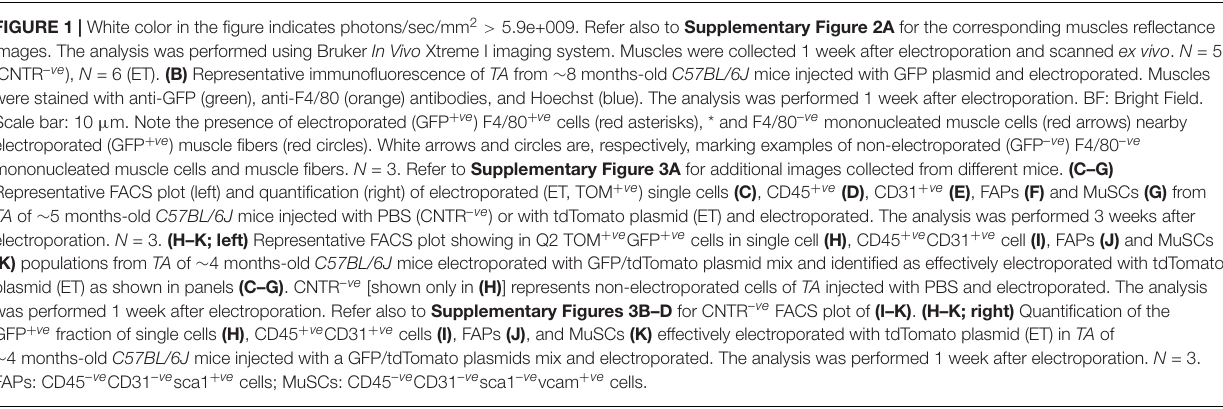
FIGURE 1 | White color in the figure indicates photons/sec/mm 2 > 5.9e+009. Refer also to Supplementary Figure 2A for the corresponding muscles reflectance images. The analysis was performed using Bruker In Vivo Xtreme I imaging system. Muscles were collected 1 week after electroporation and scanned ex vivo . N = 5 (CNTR – ve ), N = 6 (ET). (B) Representative immunofluorescence of TA from ∼ 8 months-old C57BL/6J mice injected with GFP plasmid and electroporated. Muscles were stained with anti-GFP (green), anti-F4/80 (orange) antibodies, and Hoechst (blue). The analysis was performed 1 week after electroporation. BF: Bright Field. Scale bar: 10 µ m. Note the presence of electroporated (GFP + ve ) F4/80 + ve cells (red asterisks), * and F4/80 – ve mononucleated muscle cells (red arrows) nearby electroporated (GFP + ve ) muscle fibers (red circles). White arrows and circles are, respectively, marking examples of non-electroporated (GFP – ve ) F4/80 – ve mononucleated muscle cells and muscle fibers. N = 3. Refer to Supplementary Figure 3A for additional images collected from different mice. (C–G) Representative FACS plot (left) and quantification (right) of electroporated (ET, TOM + ve ) single cells (C) , CD45 + ve (D) , CD31 + ve (E) , FAPs (F) and MuSCs (G) from TA of ∼ 5 months-old C57BL/6J mice injected with PBS (CNTR – ve ) or with tdTomato plasmid (ET) and electroporated. The analysis was performed 3 weeks after electroporation. N = 3. (H–K; left) Representative FACS plot showing in Q2 TOM + ve GFP + ve cells in single cell (H) , CD45 + ve CD31 + ve cell (I) , FAPs (J) and MuSCs (K) populations from TA of ∼ 4 months-old C57BL/6J mice electroporated with GFP/tdTomato plasmid mix and identified as effectively electroporated with tdTomato plasmid (ET) as shown in panels (C–G) . CNTR – ve [shown only in (H) ] represents non-electroporated cells of TA injected with PBS and electroporated. The analysis was performed 1 week after electroporation. Refer also to Supplementary Figures 3B–D for CNTR – ve FACS plot of (I–K) . (H–K; right) Quantification of the GFP + ve fraction of single cells (H) , CD45 + ve CD31 + ve cells (I) , FAPs (J) , and MuSCs (K) effectively electroporated with tdTomato plasmid (ET) in TA